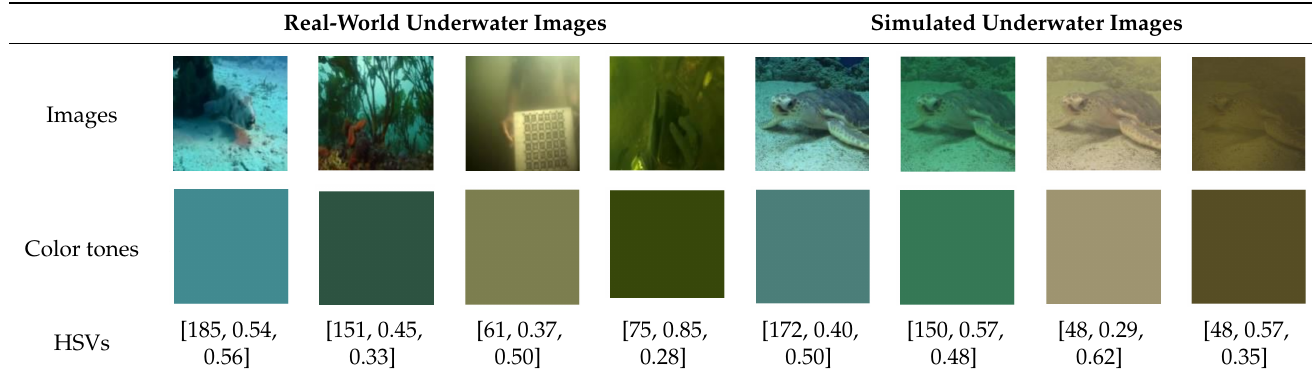
Table 1. Color tones and HSVs of real-world underwater images and simulated underwater